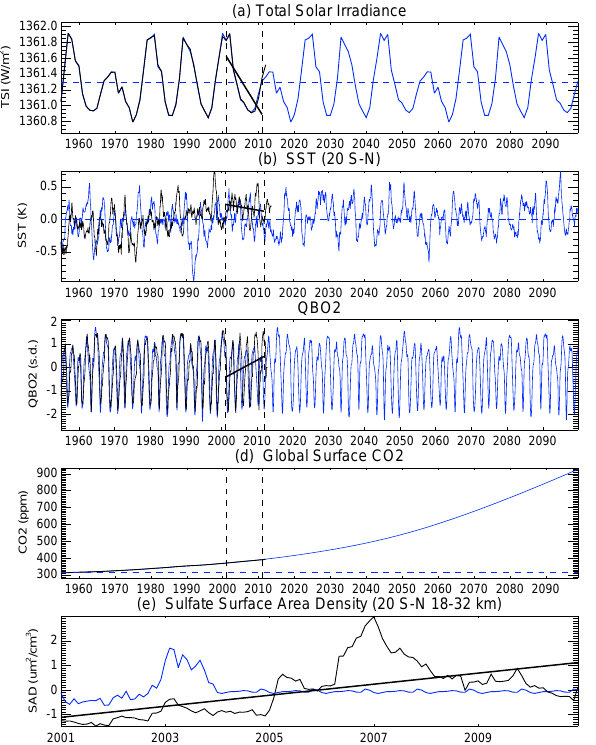
Figure 1. Time series of forcing data sets used for the simulations from 1955 through 2099. (a) TSI from observations (black), Natural (solid blue) and SolarMean (dashed blue) runs. (b) SST anomalies from HadISSTs (black), Natural (solid blue) and FixedSST (dashed blue) runs. (c) QBO2 (see text for details) from observations (black) and Natural (solid blue) run. (d) Global surface CO 2 concentration from observations (black, overlapped with the blue line), RCP85 (solid blue) and Natural (dashed blue) runs. (e) AOD (532nm, 18– 32km) from the CCMI (black) and the CCMVal2 (blue) projects for the time 2001–2010. The black solid straight lines in each subfigure are the linear fits of the respective forcing during